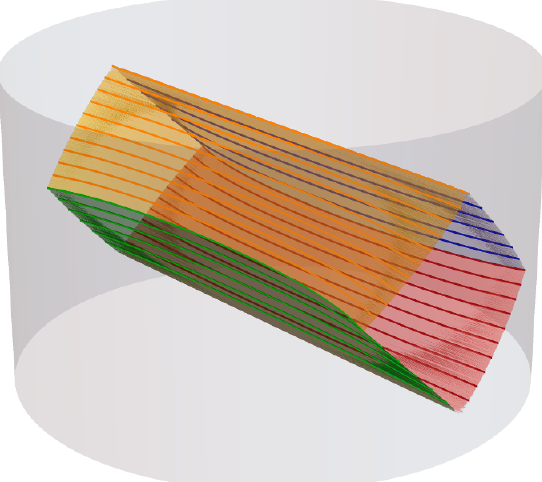
Figure 3 . A closed trajectory in the space of CFT regions. To avoid clutter and to clarify the holographic application, here we display the family of corresponding RT surfaces in the bulk of